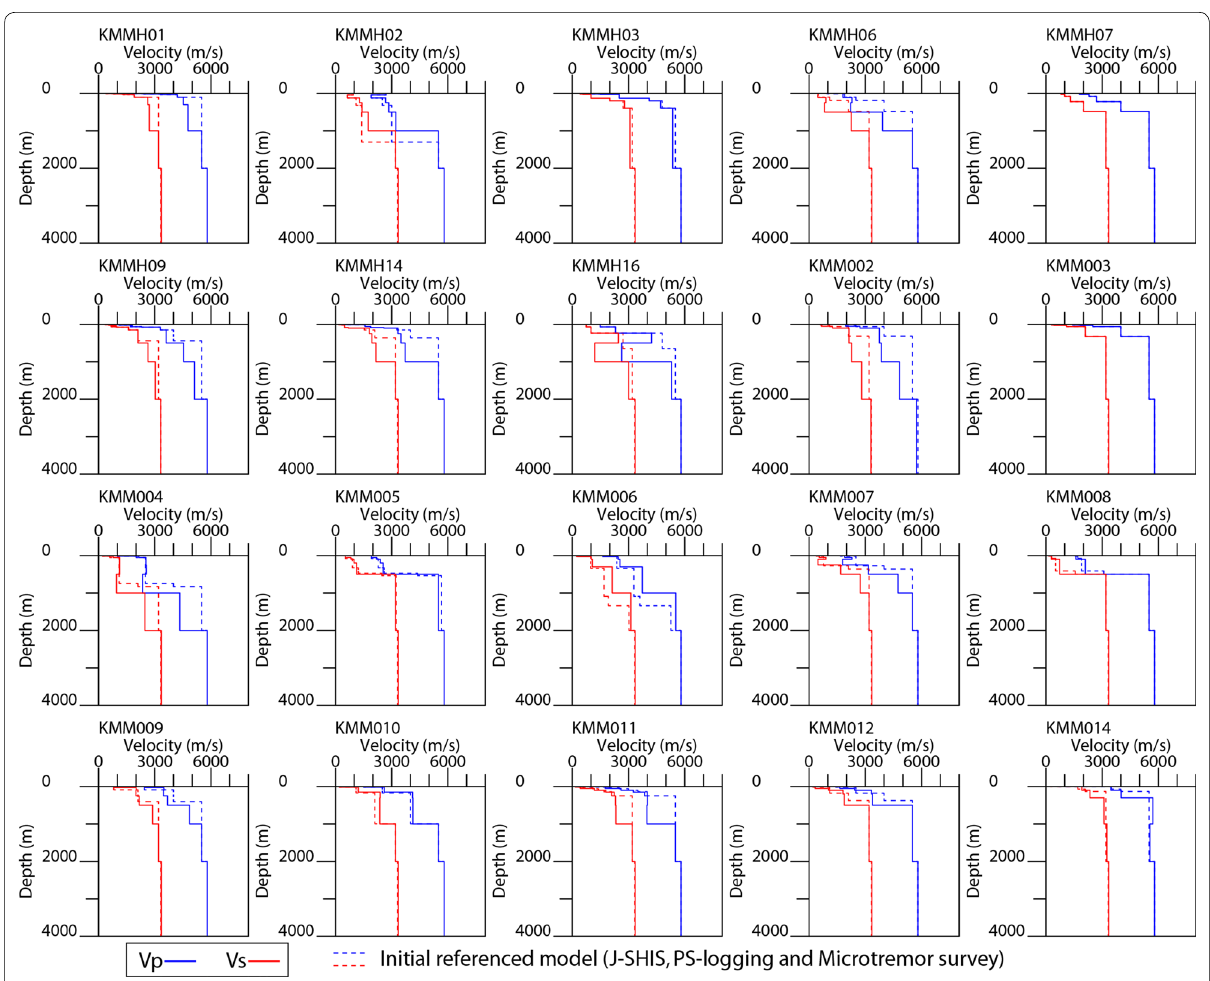
Fig. 2 Estimated velocity structure model ( solid line ) and initial velocity model ( broken line ). The microtremor array survey was operated at KMM005, KMM006, and KMM008 (Yoshida et al.